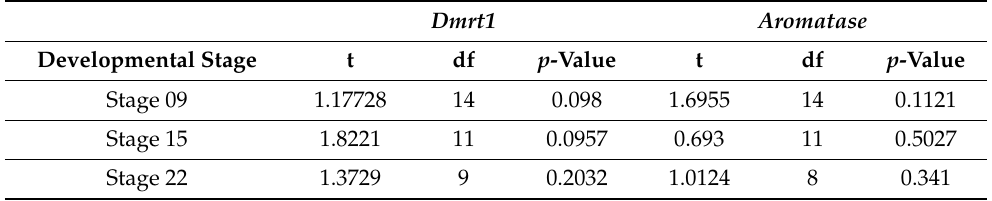
Table 2. Results of the Student’s t -test statistical analysis for Dmrt1 and Aromatase between tempera- tures at each stage